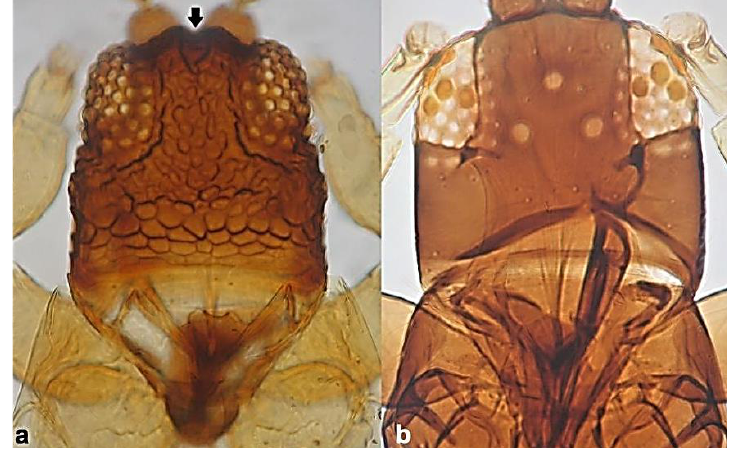
Figure 26. Head: ( a ) with reticulate sculpture and with a ridge between antennal sockets; ( b ) with no distinct sculpture and with no ridge between antennal sockets. 28 Pronotum with no long postero-angular setae (Figure 27a); fore wing with dark band